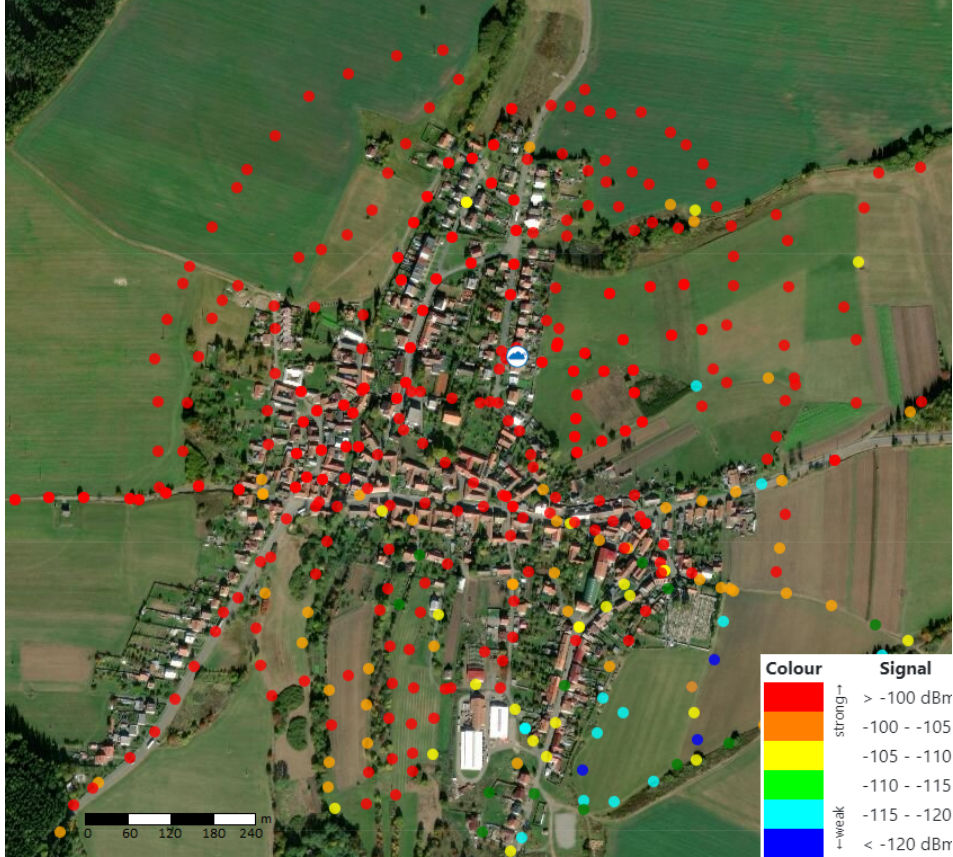
Figure 12. Measurement of the signal strength in Zdarna village (scale